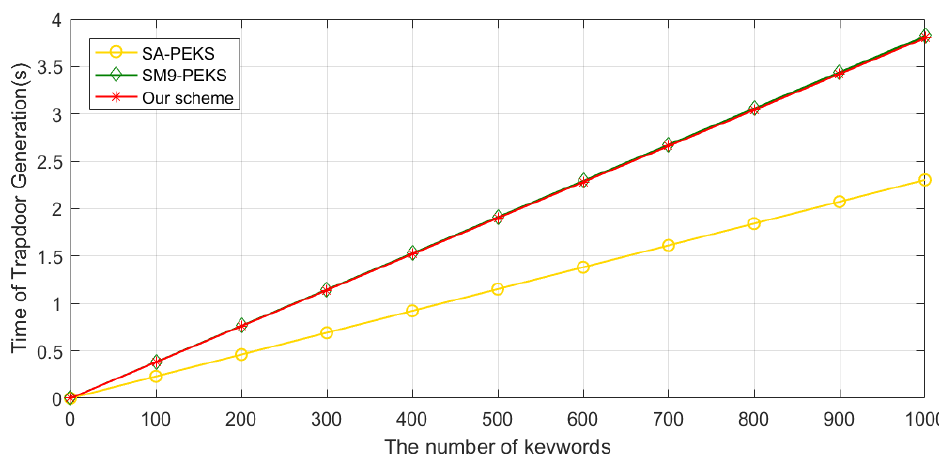
Figure 5. Computation cost of trapdoor